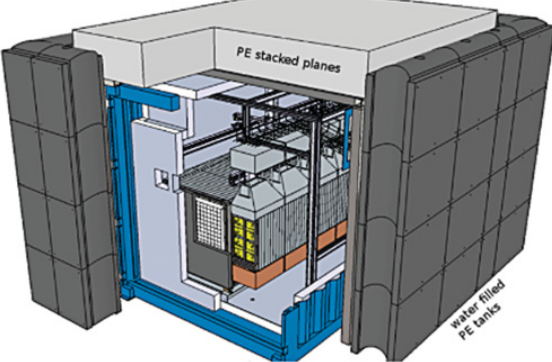
Figure 2. Top view of the fuel matrix of the BR2 tank-in- pool reactor core. The twisted design results in a compact core, allowing a detector baseline of ∼ 6m.